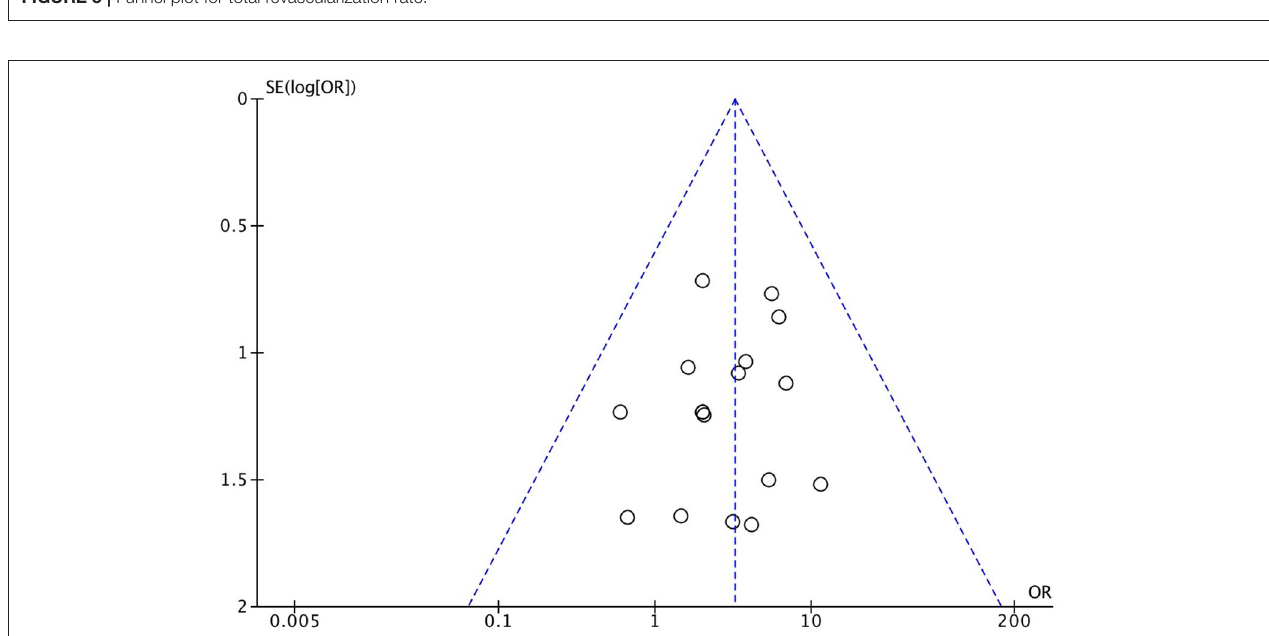
FIGURE 6 | Funnel plot for perioperative neurological